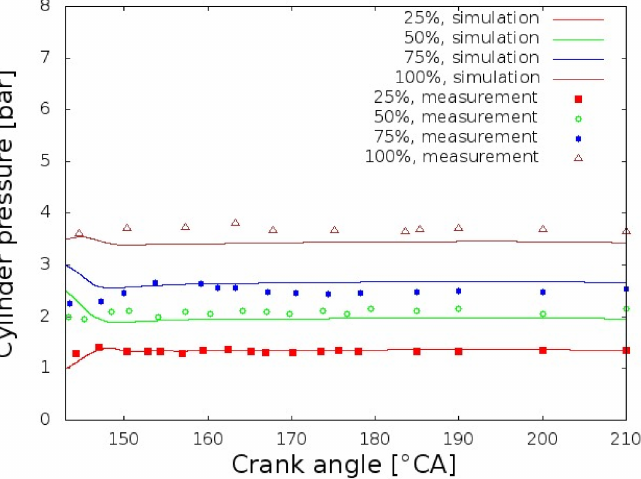
Figure 5. Cylinder pressure comparison for the scavenging interval.